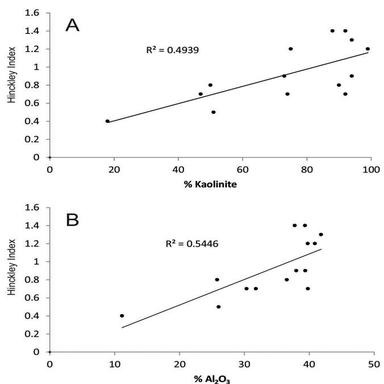
Relationships between Hinckley index and kaolinite (A) or Al2O3 (B) amounts in the samples (% w/w).